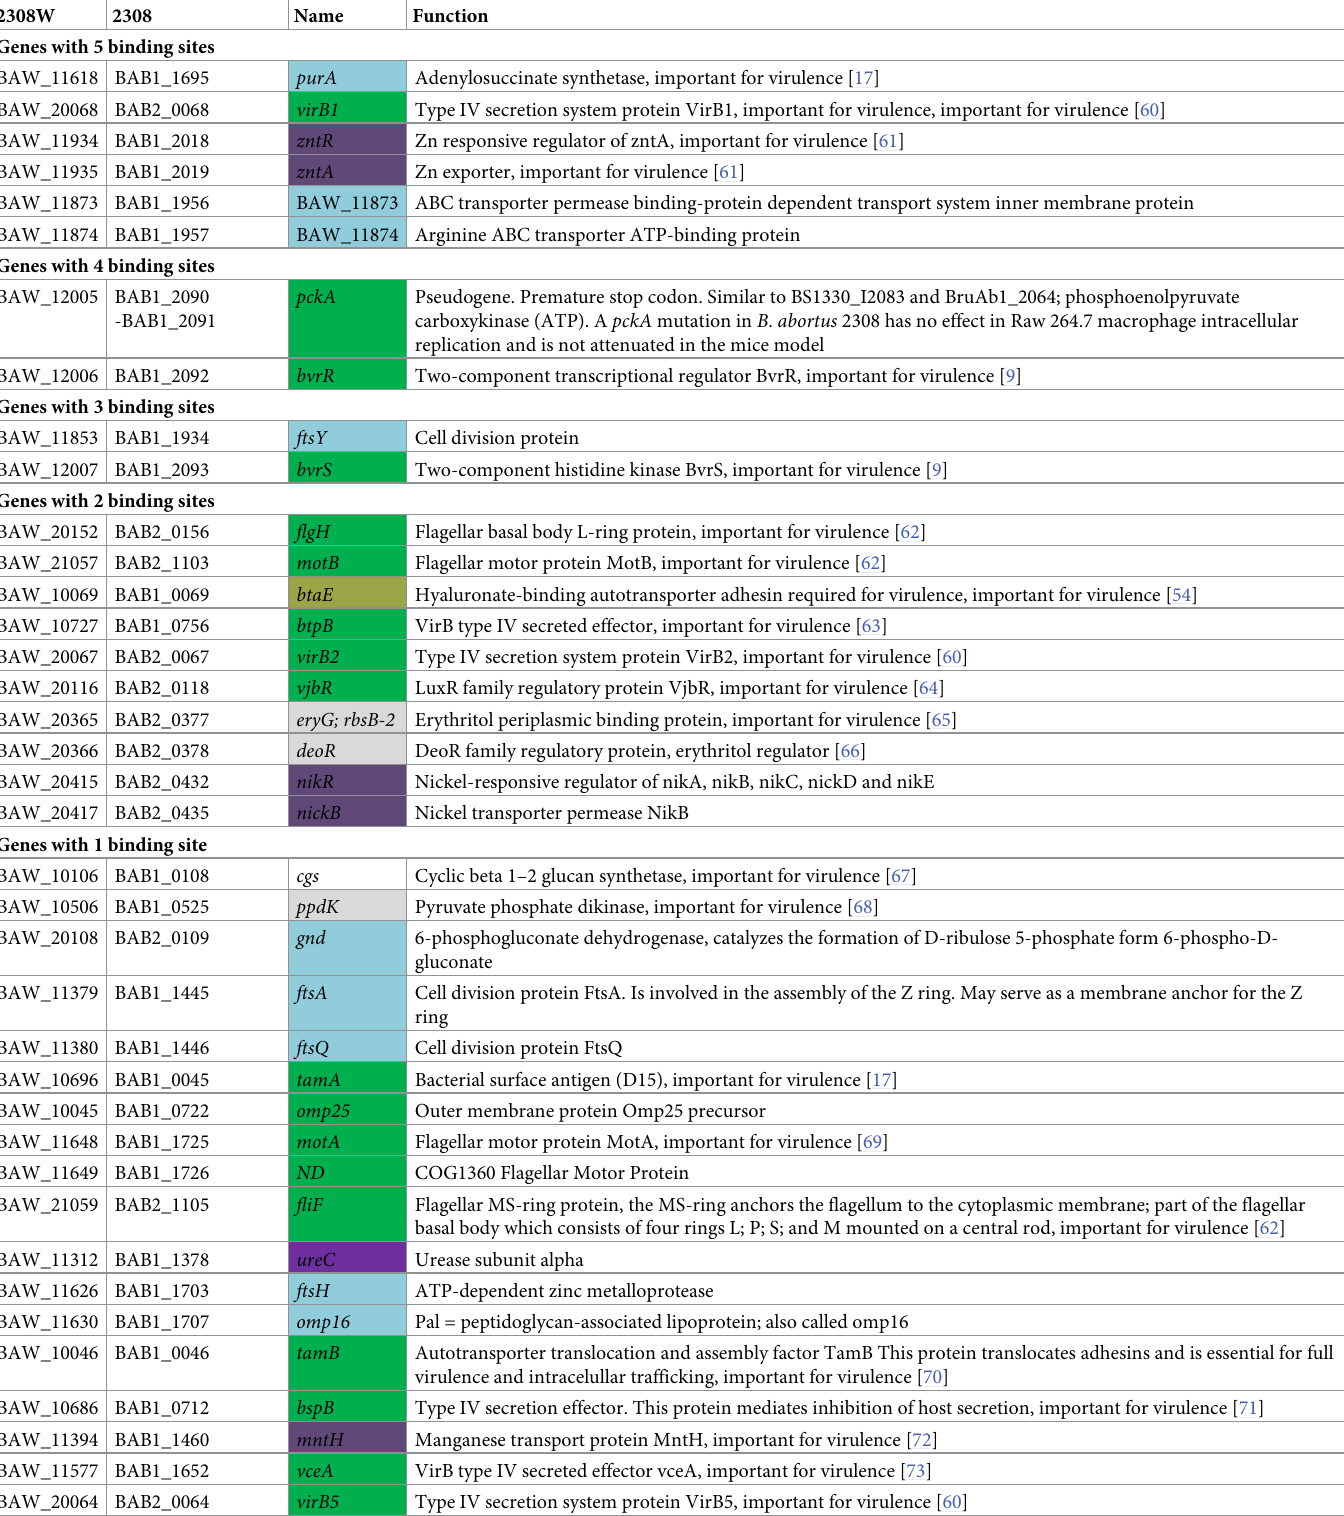
Table 3. Selection of manually curated genes of interest according to number of significant signals close or within their